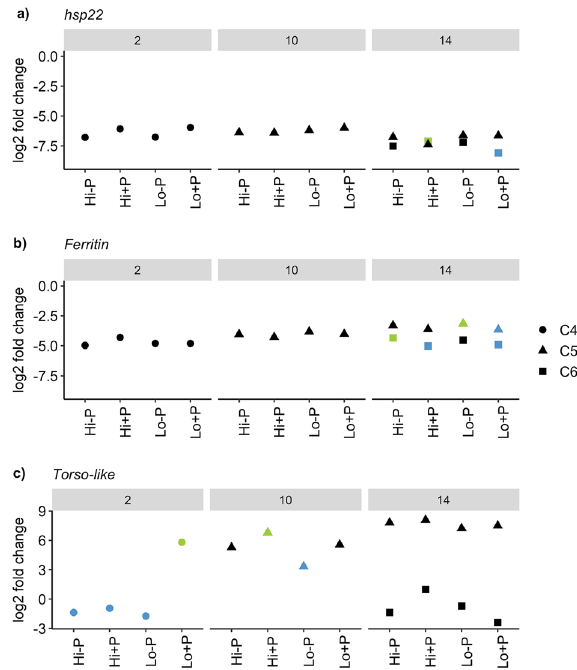
Figure 6. Gene expression of ( a ) hsp22 and ( b ) ferritin , two molecular markers of diapause, and ( c ) Torso-like , a developmental marker, in Calanus finmarchicus copepods exposed to a combination of absence or presence of a predator cue with high or low food availability, compared to the reference group ( Calanus spp. C5s in diapause). Within each day and stage, green symbols denote significant upregulation from blue symbols between treatments. Hi-P High food and no predator cue, Hi + P High food and predator cue, Lo-P Low food and no predator cue, Lo + P Low food and predator